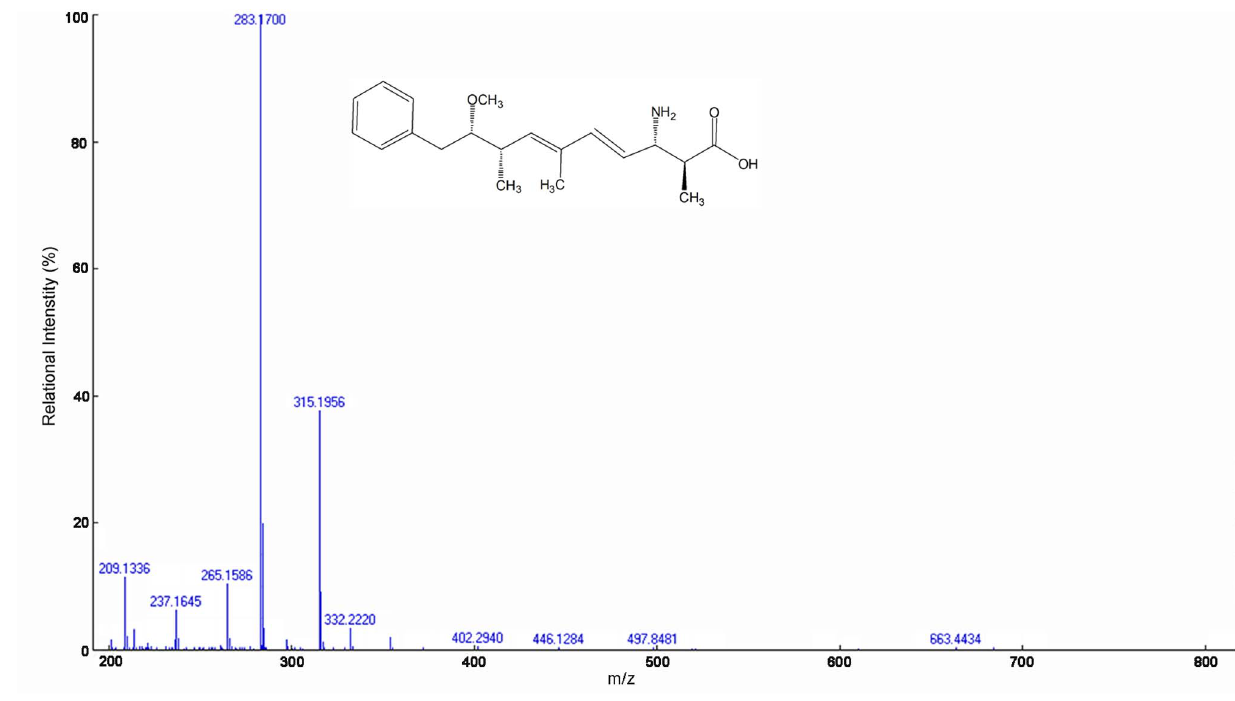
Figure 6. ESI-TOF-MS spectrum and putative structure of the biodegradation product of MC-LR and MC-RR.